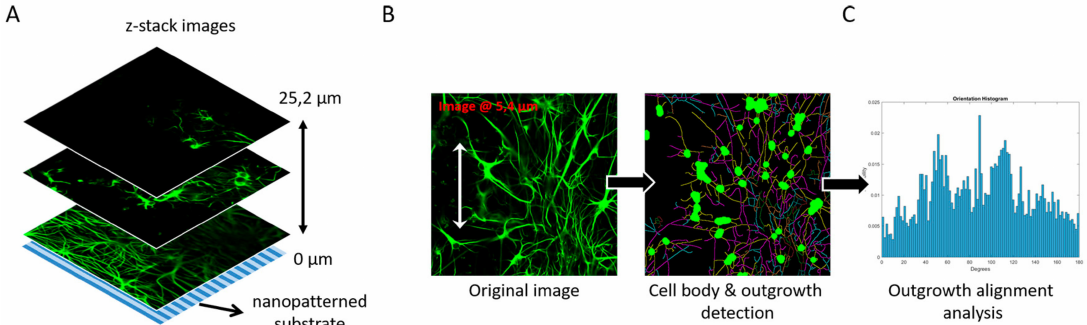
Figure 2. Overview of image-based screening analysis on z-stack images from a 3D neuronal